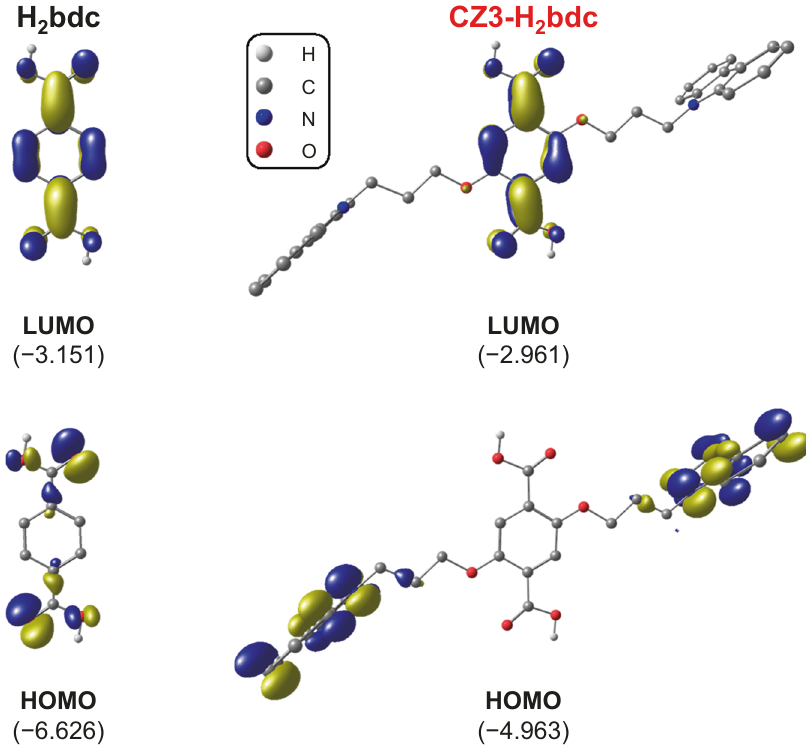
Fig. 2 Isosurface plots (isodensity value = 0.05 a.u.) of HOMO and LUMO of the H 2 bdc and CZ3-H 2 bdc ligands. Electronic energies (eV) are in parenthesis. Non-essential hydrogens are not